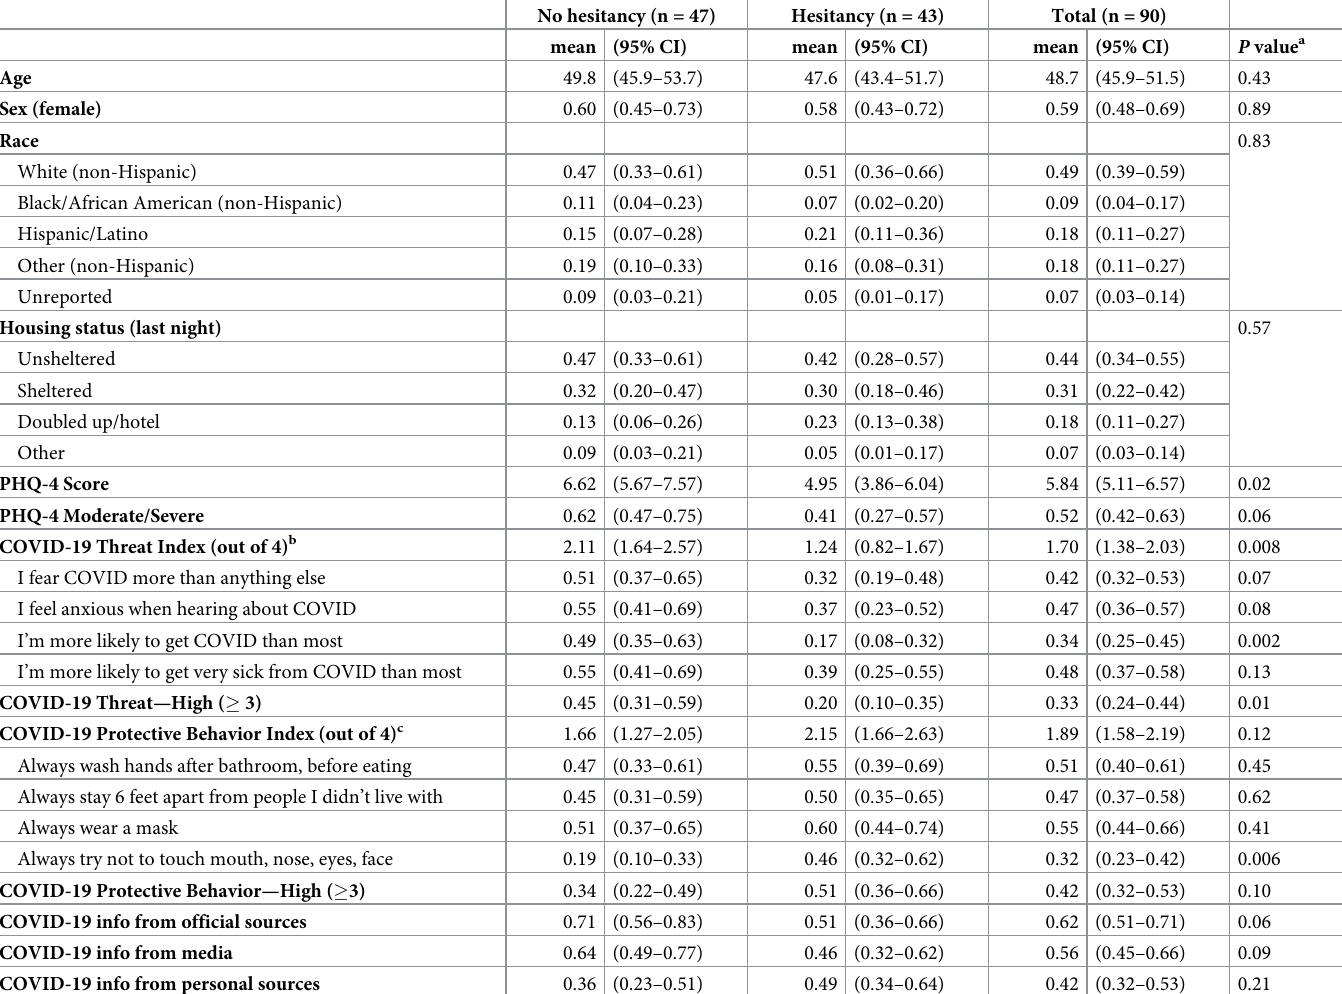
Table 1. Summary statistics by COVID-19 vaccine